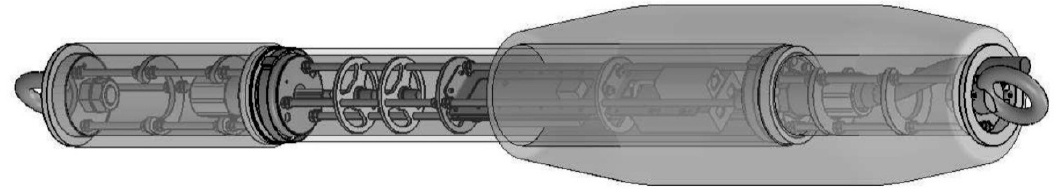
Figure 6. Perspective drawing of the single acoustic module.